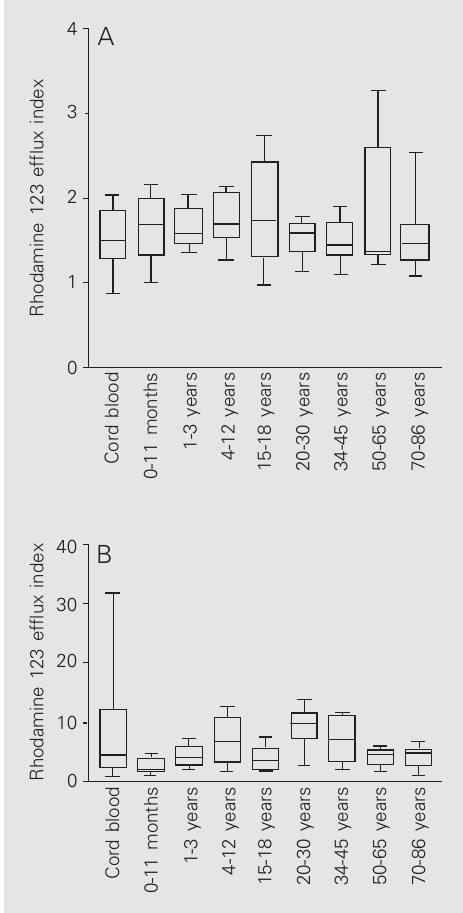
Figure 3. Variation of P-glyco- protein function in B CD19+ (A) and NK CD3-CD16+CD56+ (B) lymphocytes with age. P-glyco- protein function is reported as the ratio of rhodamine 123 mean fluorescence in the pres- ence and in the absence of verapamil (rhodamine 123 efflux index). P-glycoprotein activity was low in all age groups and was not influenced by